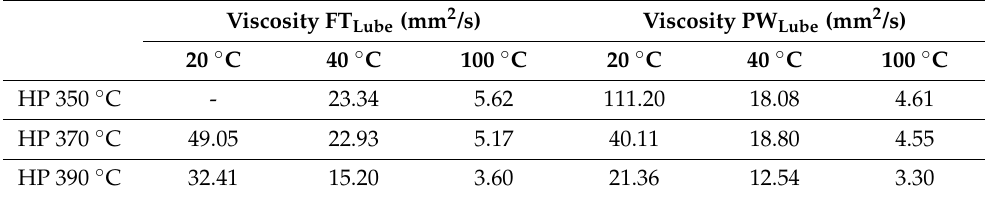
Table A3. Viscosity Measurements of FT and PW Lubricants at Constant Sher Rate 50 s − 1